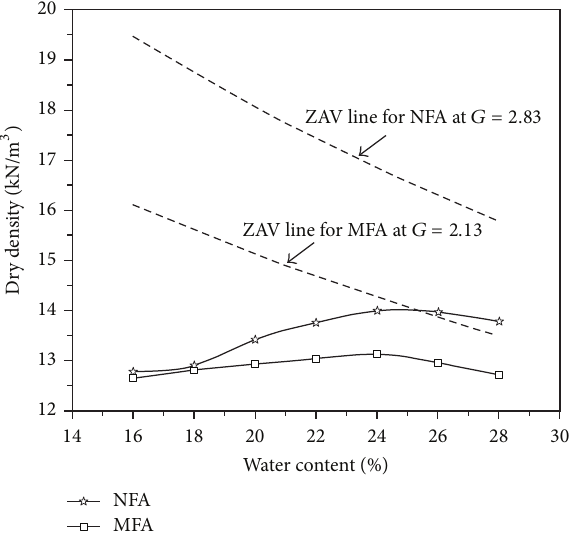
Figure 6: Dry density and water content relationships of the fly